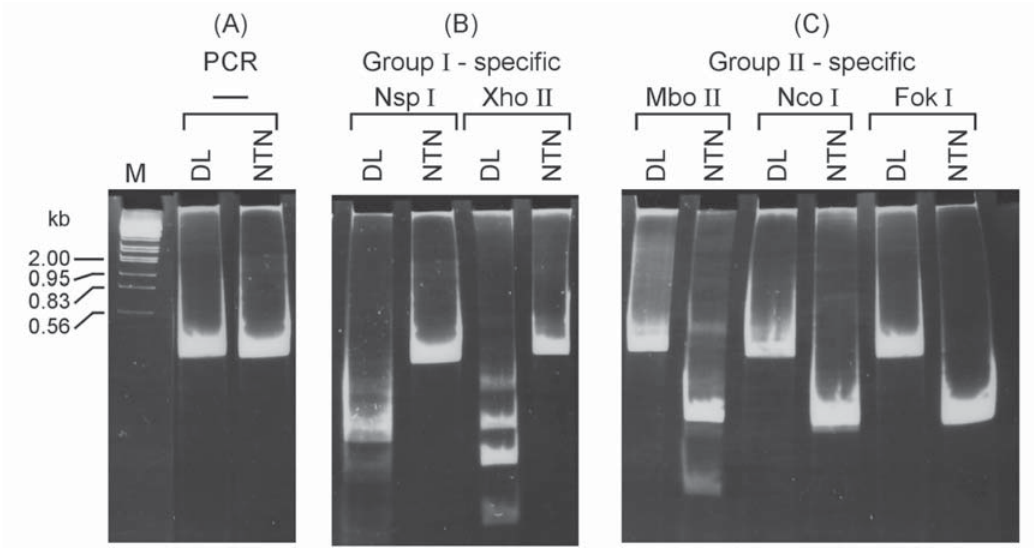
Fig. 3. Restriction endonuclease cleavage patterns of groups I and II. PCR products, amplified with primers I and II (380 nt long) of isolates DL (group I) and NTN-H (group II), were cleaved with the following restriction endonucle- ases: (A) Xho II and Nsp I (group I-specific), and (B) Mbo II, Fok I, and Nco I (group II-specific). The digests were fractionated in 6% polyacrylamide gel by electrophoresis and stained with ethidium bromide. M-size marker of Eco R I / Hin d III cleaved Lambda